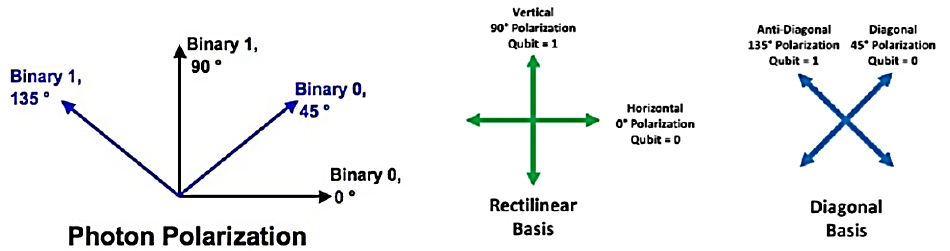
Figure 1. Encoding of the bit in protocol BB84.